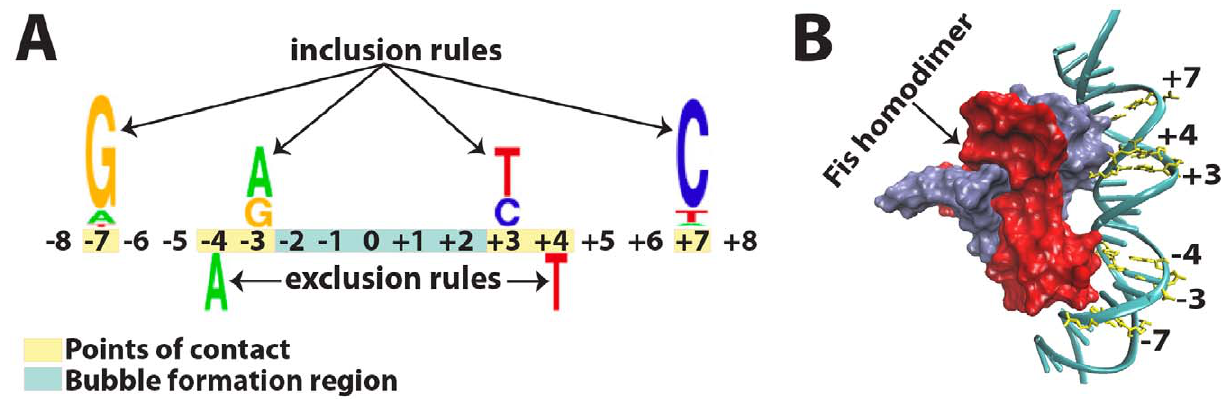
Figure 1. Fis-DNA points-of-contact and inclusion/exclusion rules. (A) Qualitative depiction of the sequence logo for a palindromic Fis binding site, emphasizing inclusion rules (above the numbers indicating the locations in the binding segment) and exclusion rules (below the numbers). The rules were derived from previous studies (see the main text). Yellow indicates direct points-of-contact or positions of inclusion/ exclusion rules; blue indicates location of the Fis bubble formation region. The colors of the nucleic acids are chosen as the commonly used ones in consensus sequence logos. (B) Crystal structure example of Fis-DNA binding complex visualized by the data from PDB code 3IV5 as submitted in [51]. The nucleotides (direct points-of-contact) participating in the inclusion/exclusion rules are labeled and highlighted in yellow.